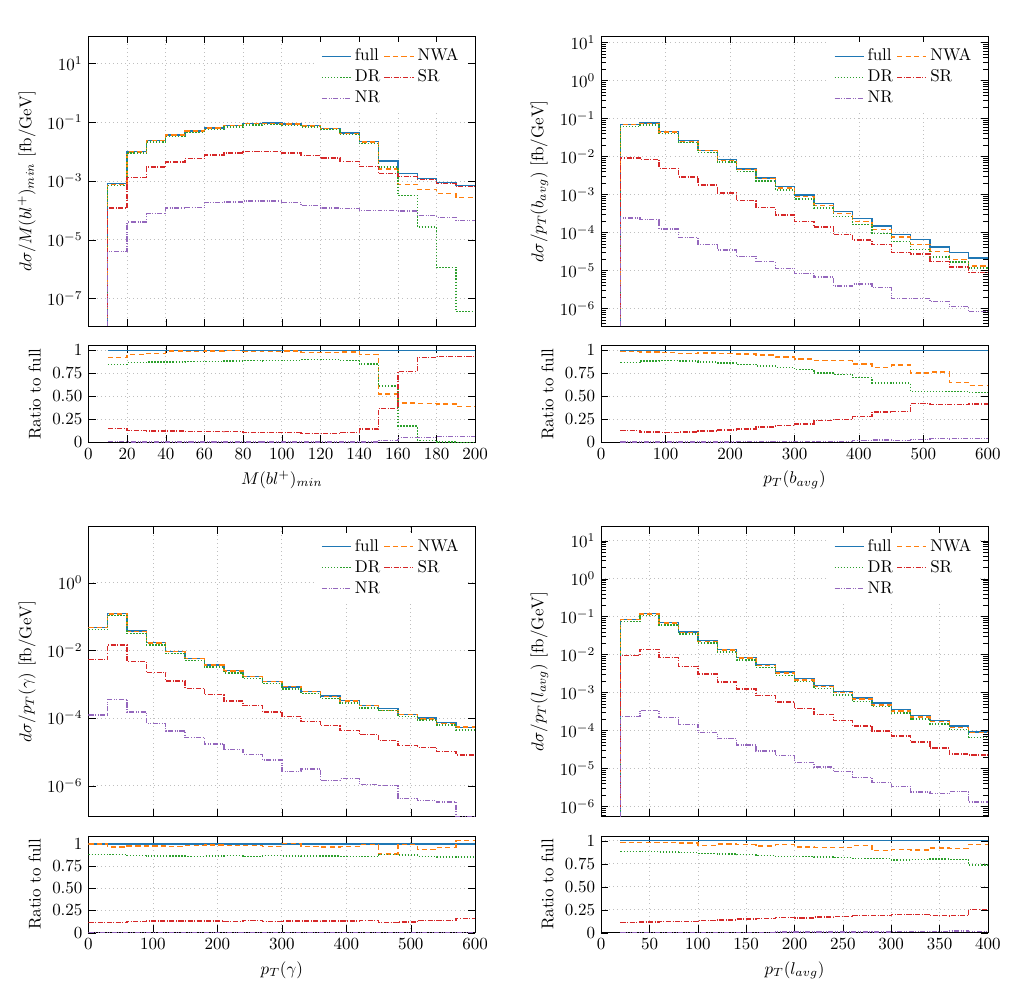
Figure 7 . The pp e + (cid:23) e (cid:22) (cid:0) (cid:22) (cid:23) (cid:22) b (cid:22) b(cid:13) di(cid:11)erential cross section distribution as a function of the ! minimum invariant mass of the b -jet and the positron, the (averaged) transverse momentum of the b -jet, the hard photon and the (averaged) charged lepton at the LHC run II with p s = 13 TeV. The upper plots show absolute NLO QCD predictions for DR, SR and NR regions. Also shown are NLO results for full o(cid:11)-shell and NWA case. The ratios of these contributions to the full o(cid:11)-shell result are also shown. Results are given for (cid:22) 0 = H T = 4 and the CT14 PDF